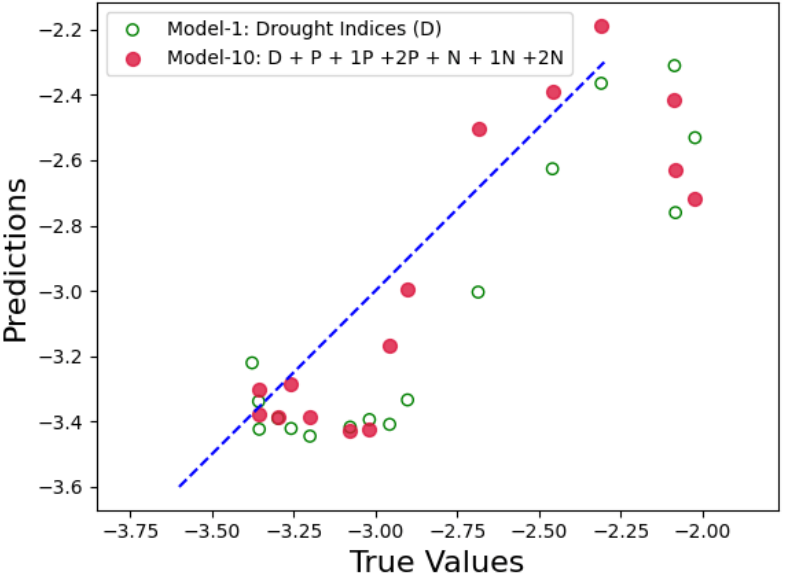
Figure 16. Result on unseen data during January-April 2021 using Deep Learning and Model 10 from Table 3. The x-axis represents the true or the actual PDSI values and the y-axis represents the predicted PDSI values. The red circles are the predictions by Model 10 and the green hollow circles in the figures are the predictions by the control run model. The blue dashed line is the reference line to test the model performance.